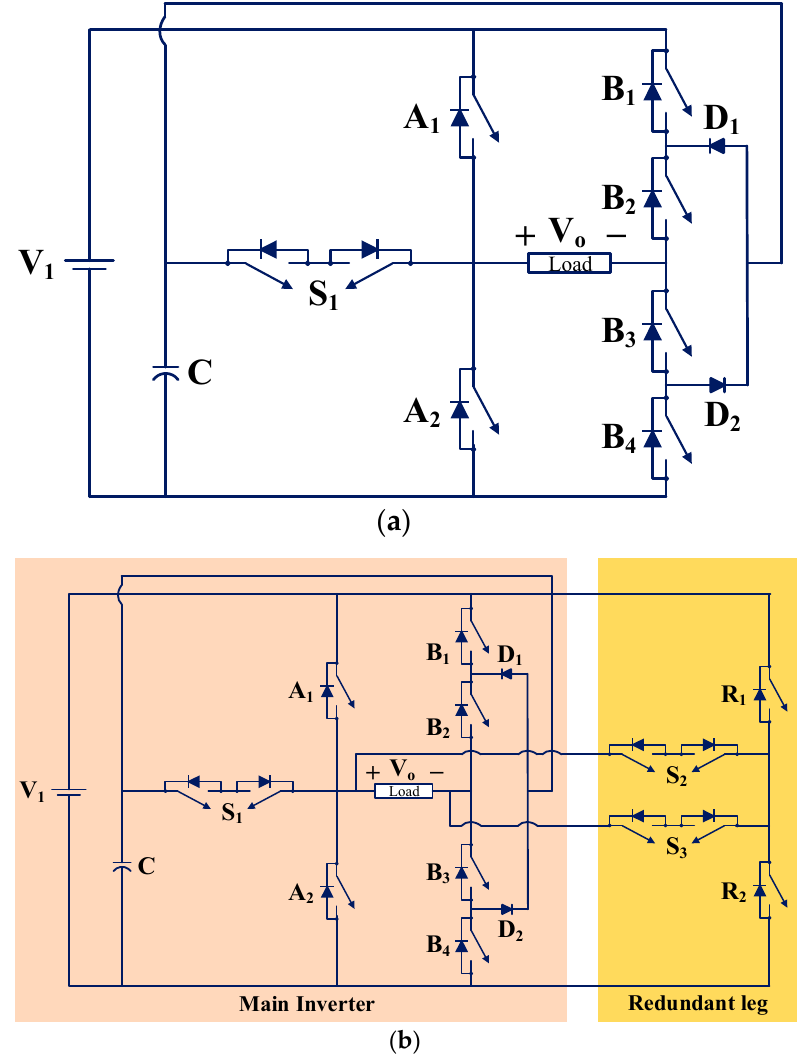
Figure 9. ( a ) Single-phase five-level MLI for partial fault tolerance (TP8) [31]. ( b ) Single-phase five-level MLI for complete fault tolerance (TP9) [31].